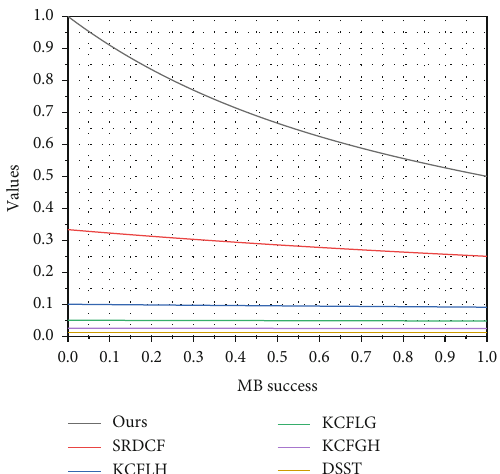
Figure 5: Success rate graph for each algorithm on motion blur test